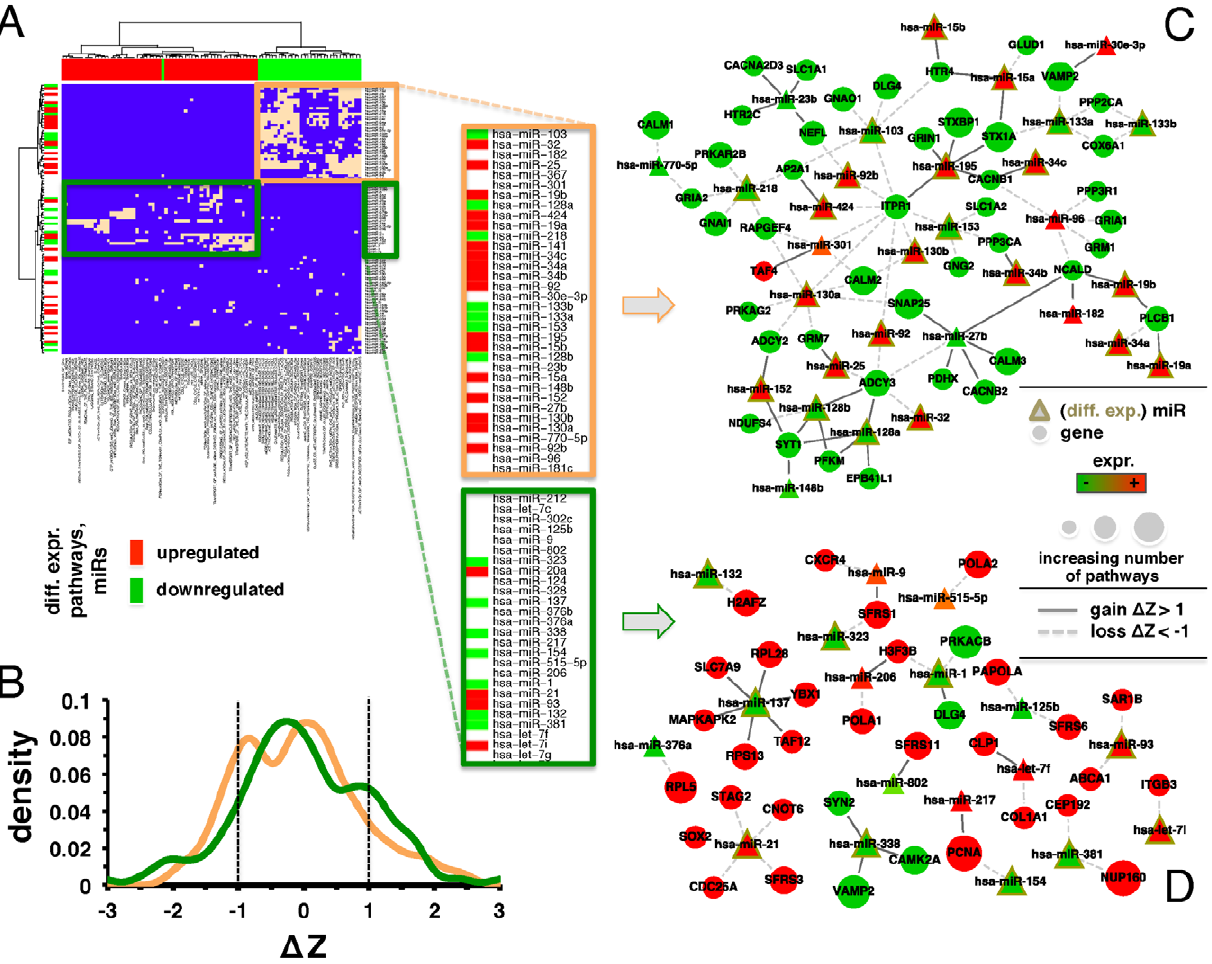
Figure 3. Analysis of correlation change in glioblastomas. ( A ) Focusing on a set of 99 overlapping overall important miRs (OIM) in GBMs, ovarian and breast cancers, we indicated OIMs and their corresponding differentially expressed pathways in GBMs (peach boxes). In such a binary matrix we observed two large clusters that distinguished largely between either up- or down regulated pathways (orange, green boxes). In ( B ) we calculated the change of expression correlation, D Z, for all pairs of OIMs in such clusters and their interacting leading edge genes (LEG) in the corresponding pathways. In particular, we observed multimodal distributions with local peaks around D Z= 6 1.0 (dashed lines). In ( C ) and ( D ) we mapped all interactions between OIMs and LEGs of pathways that corresponded to the observed clusters. Specifically, we only accounted for interactions with a correlation change | D Z| . 1.0.